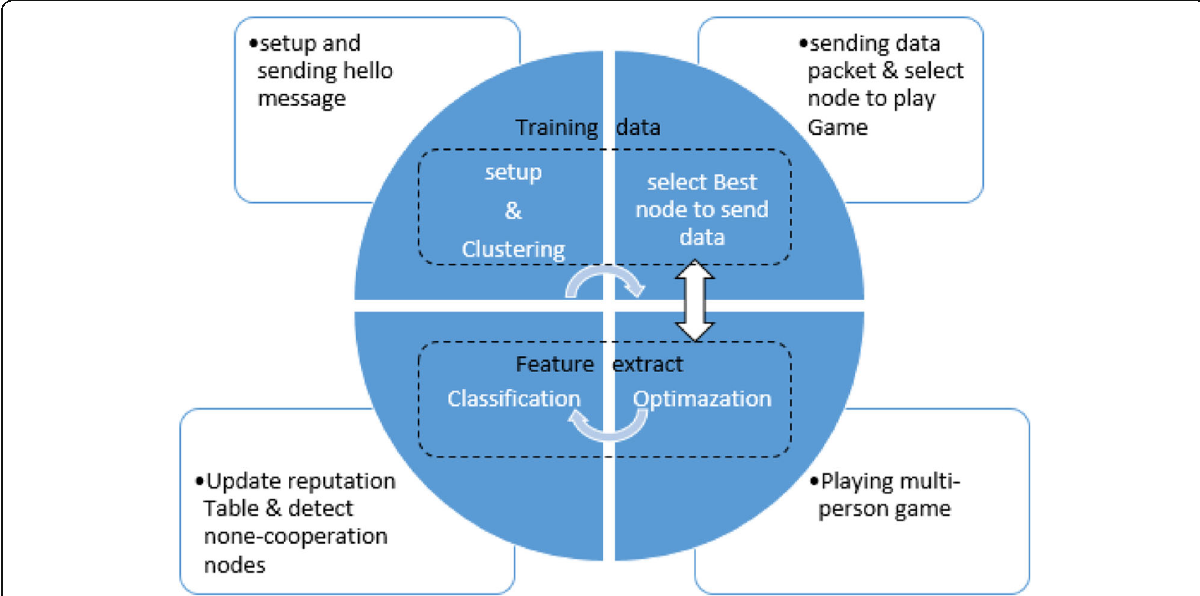
Fig. 2 Multi-step detection mechanism in block